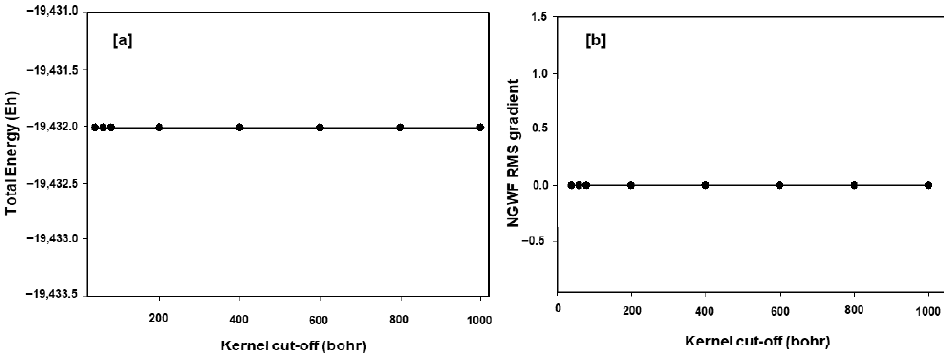
Figure 12. The figure shows the effect of the kernel cut-off on the ( a ) total energy and ( b ) NGWF RMS gradient for a 1296 atoms Mn 2 O 4 spinel structure.